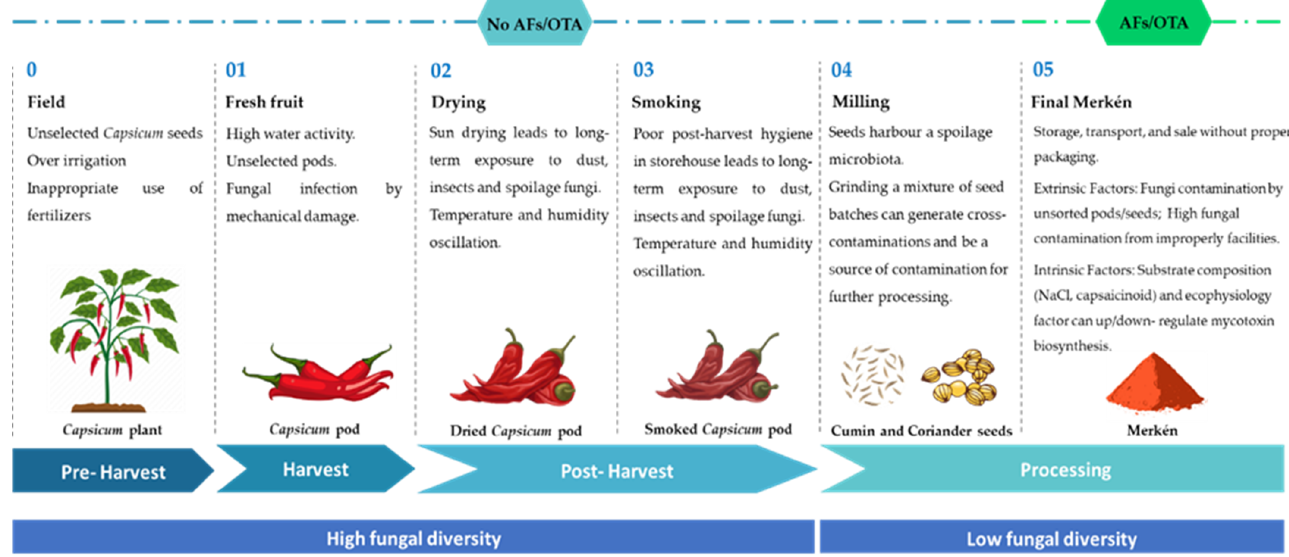
Figure 3. Overview of critical points for contamination with spoilage fungi and AFs/OTA, according to results of the present study. The main factors affecting food safety at each point of the Merkén production chain are highlighted.